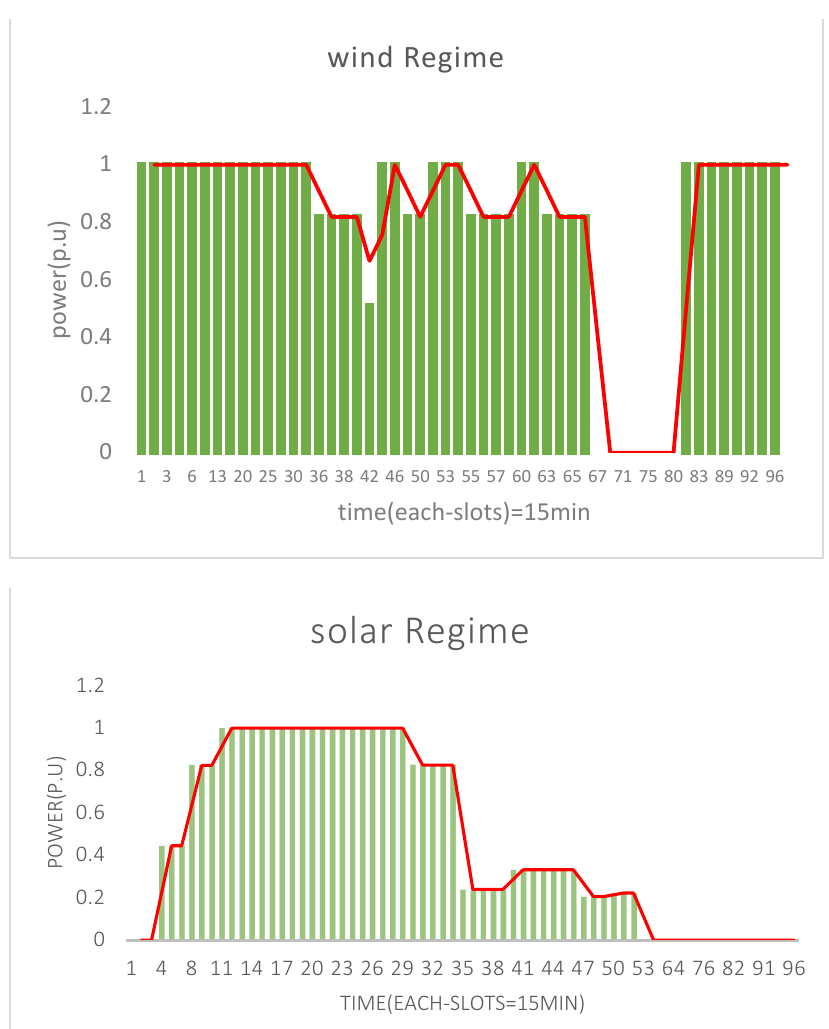
Figure 3. Solar power generation regime and wind turbine power generation regime.